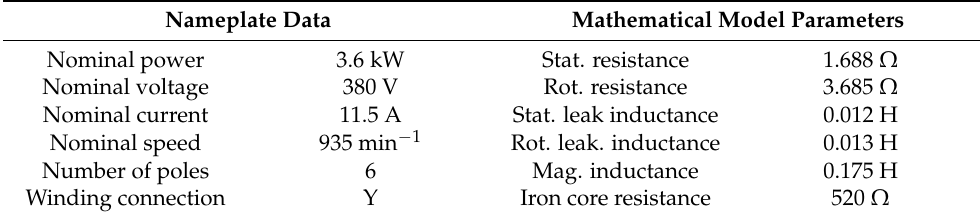
Table A1. Induction motor nameplate data and mathematical model parameters.